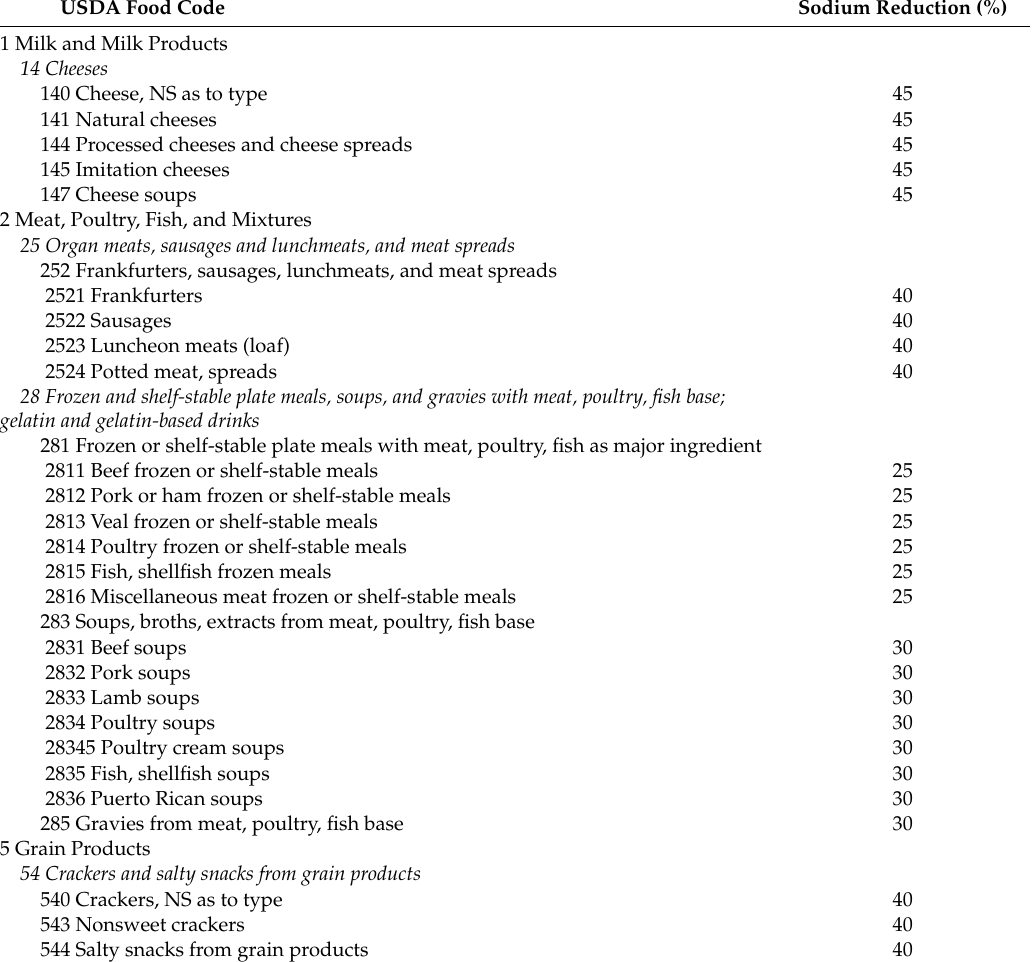
Table 2. Sodium reduction assumptions due to incorporation of glutamates by USDA food code 1 USDA Food Code Sodium Reduction